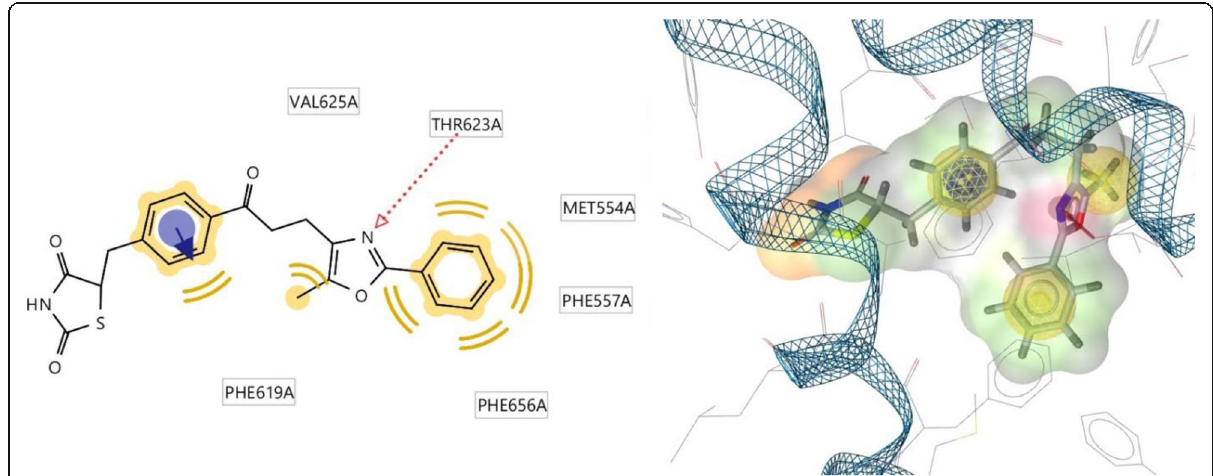
Fig. 5 The binding mode of Darglitazone within the active site of 5VA3. The hydrogen bond is presented in red-dotted line and aromatic interaction in